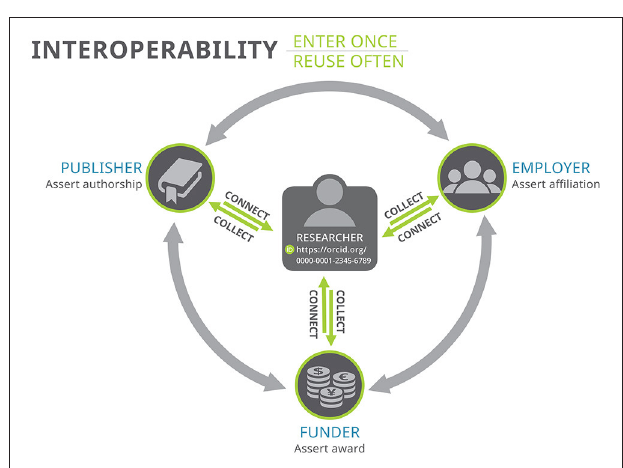
FIGURE 3 | The virtuous circle of interoperability (ORCID CC0